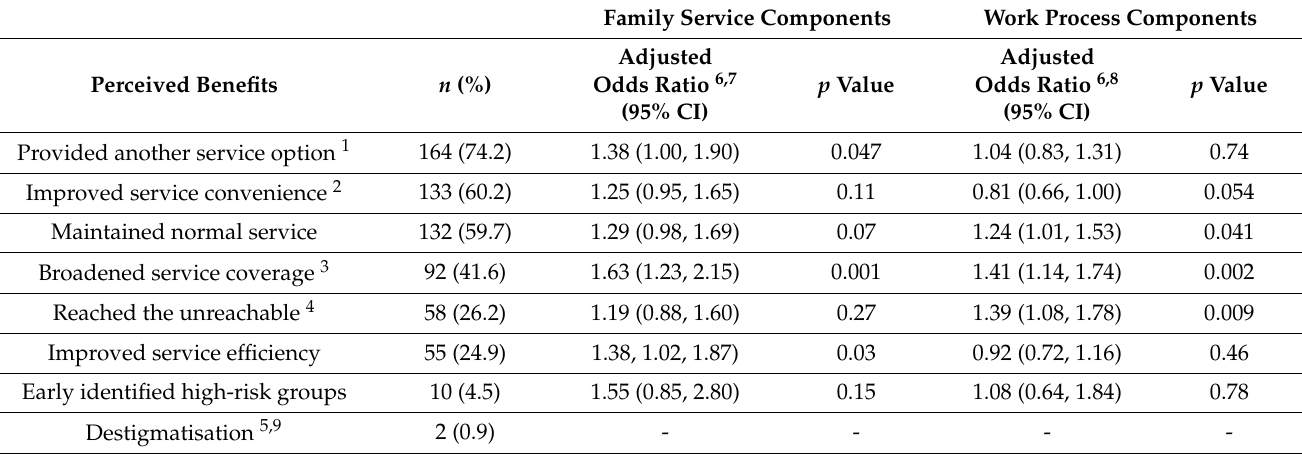
Table 5. Perceived benefits and its association with the number of family service components with a perceived increase in ICT use during the COVID-19 pandemic ( n =